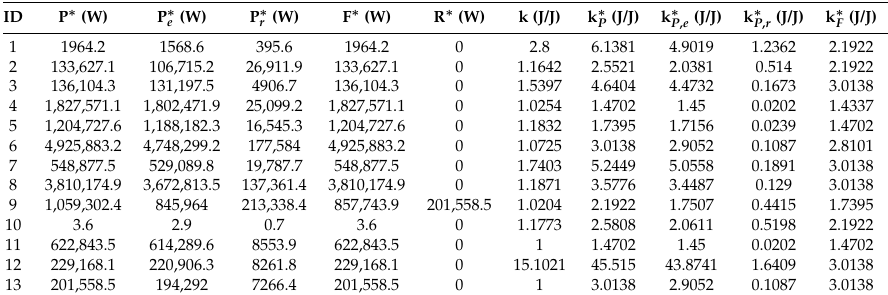
Table 7. Exergy costs for each process of the SOFC-VAR system.